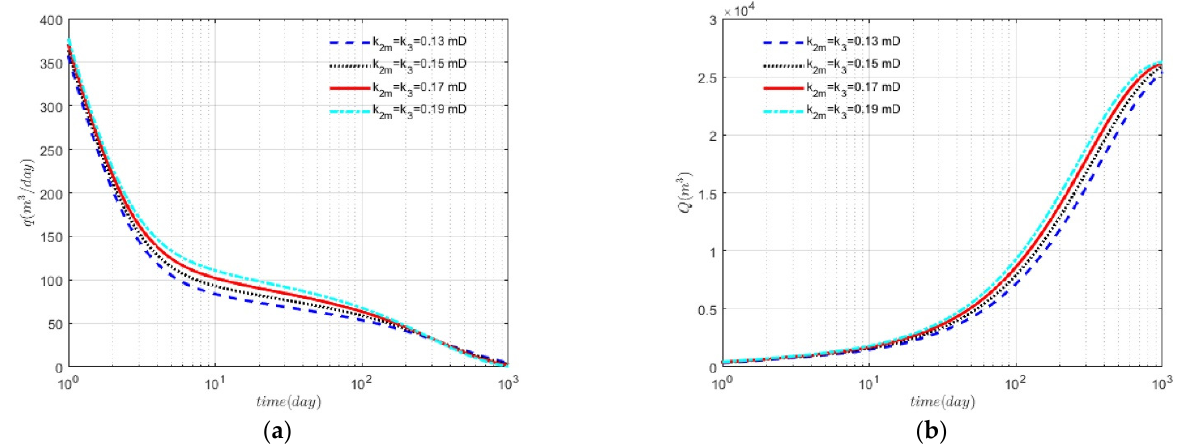
Figure 8. The effect of matrix permeability on productivity: ( a ) effect of matrix permeability on well production rate; ( b ) effect of matrix permeability on cumulative production rate.